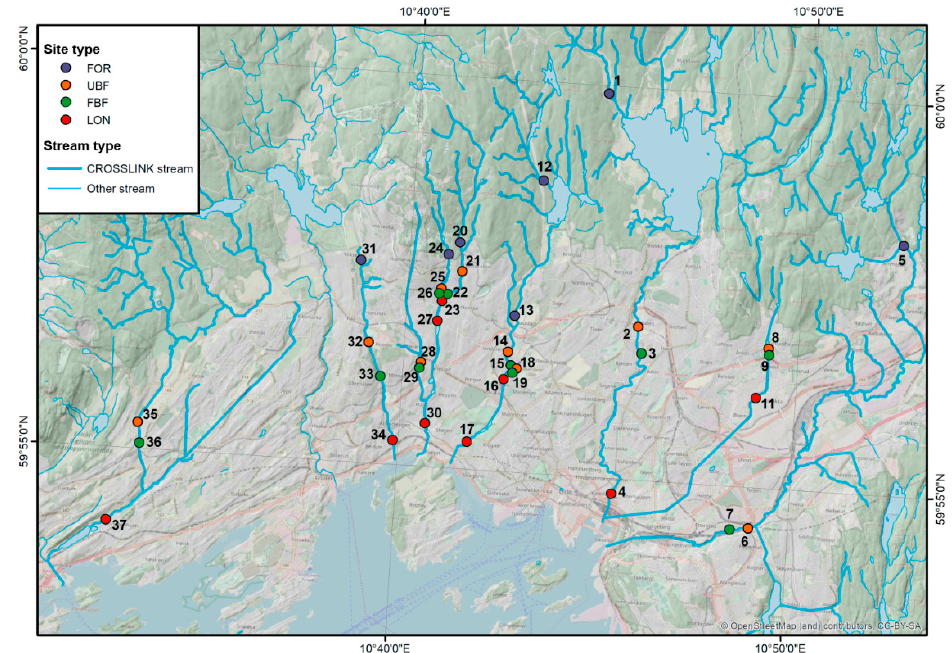
Figure 1. The Oslo Fjord basin with study streams and sites highlighted. Different colors indicate site types: FOR = pristine forested reference site; UBF = unbuffered paired urban site; FBF = forested buffered paired urban site; LON = downstream longitudinal urban matrix site. For further site details, see Table S1 (Supplementary Materials).